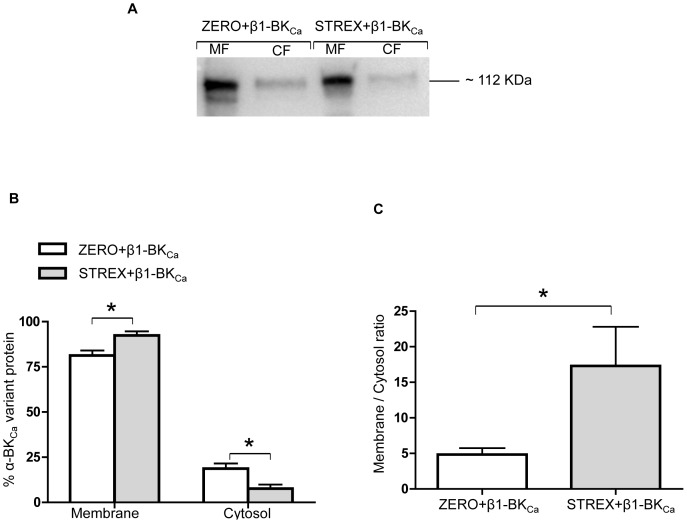
The effect of β1-BKCa subunit on cell surface expression of α-BKCa splice variants.Co-transfection of β1-BKCa subunit has little apparent impact on cell surface expression of α-BKCa ZERO or STREX variants. (A) Representative Western blot showing levels of membrane (MF), and cytosolic (CF) fractions of α-BKCa protein in CHO-K1 cultured cells, transfected with either α-BKCa splice variants ZERO or STREX. (B) In the CHO-K1 cell culture system, α-BKCa STREX variant shows dominant cell surface expression when co-transfected with β1-BKCa. Results are shown for n = 5 separate experiments and are presented as mean ± SEM (*P<0.05, unpaired t-test). (C) Membrane to cytosolic ratio for the expression of ZERO or STREX proteins when co-transfected with β1-BKCa in cultured CHO-K1 cells. Results are shown for n = 5 separate experiments and are presented as mean ± SEM (* P = 0.05, unpaired t-test).